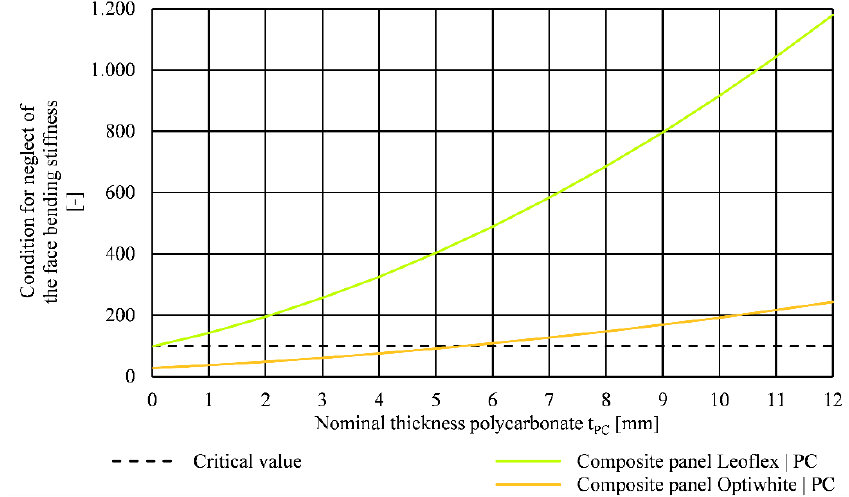
Fig. 5 Thin face approximation for thin glass-polycarbonate composite panels with thin glass Leoflex (t g = 0.85 mm) or thin glass Optiwhite (t g = 2.00 mm) and two polymer interlayers (t TPU = 2.00 mm). The nominal thickness of polycarbonate